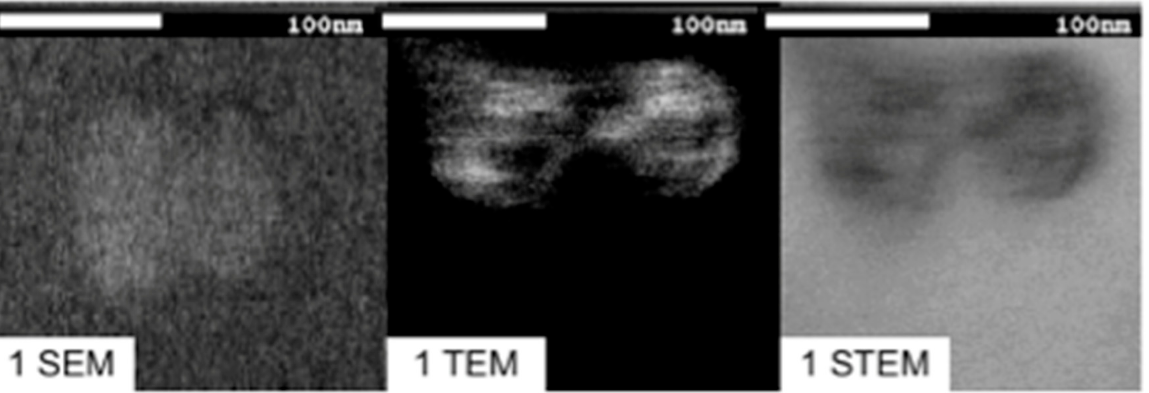
Figure 5. SEM, TEM, and STEM images of a sample of lipomics from formulation 8.2 loaded with uranyl acetate.